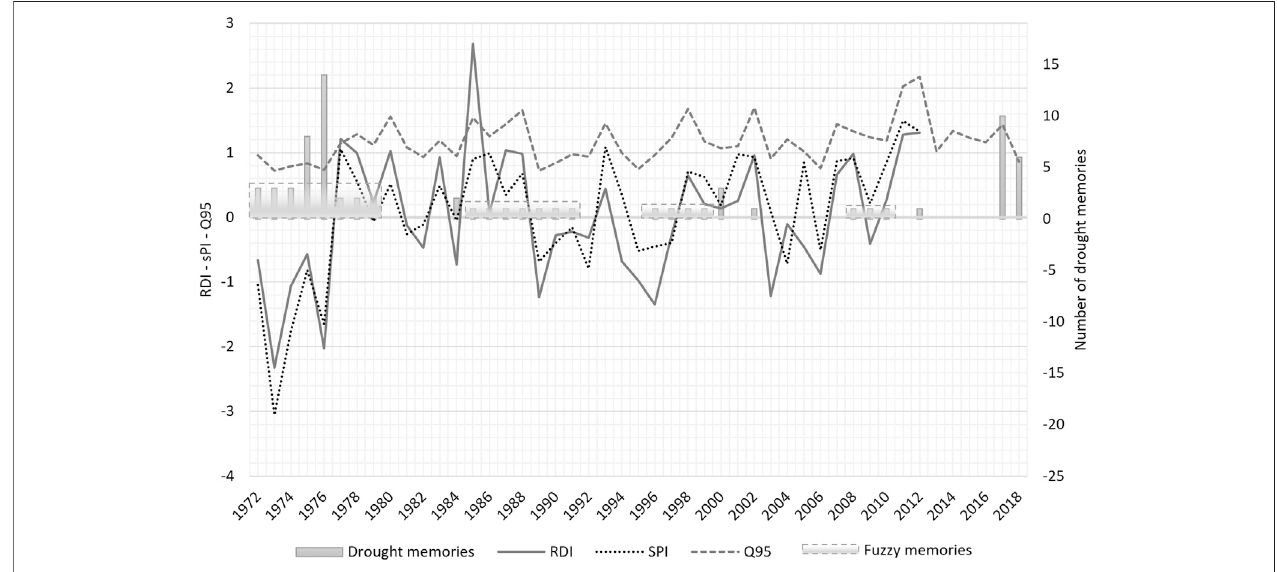
FIGURE 6 | Drought memory timelines overlaid with RDI, SPI and Q 95 data (1972 – 2012). Q 95 data were available up to 2018.